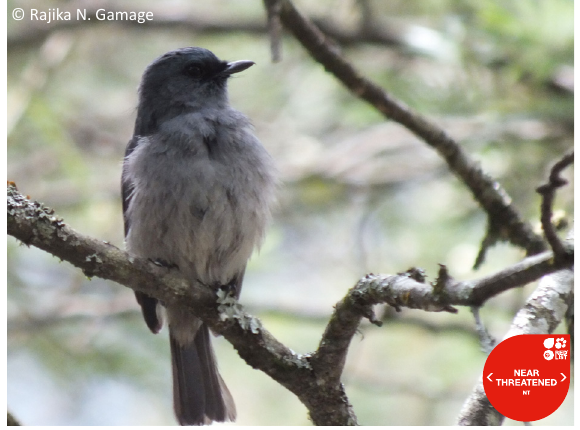
Image 12. Brown-capped Babbler Pellorneum fuscocapillus